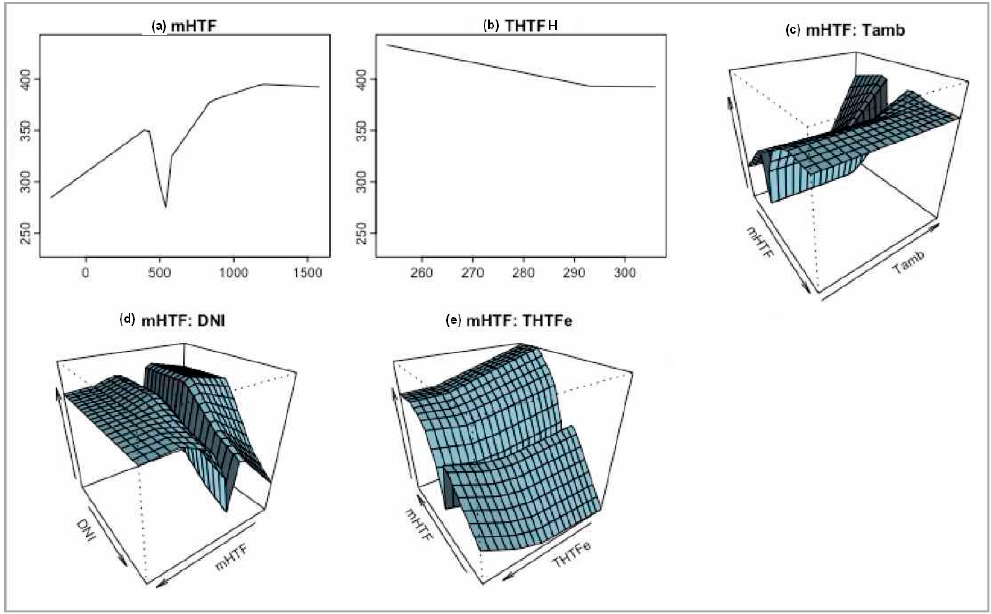
Figure 5. Graphical representation of the terms that constitute the MARS model: ( a ) first-order term of the variable mHTF (kg/s); ( b ) first-order term of the variable THTFC (cold HTF temperature in °C); ( c ) second-order term of the variables mHTF and ambient temperature; ( d ) second-order term of the variables mHTF and DNI (W/m 2 ); and ( e ) second-order term of the variables mHTF and THTFC (cold HTF temperature).